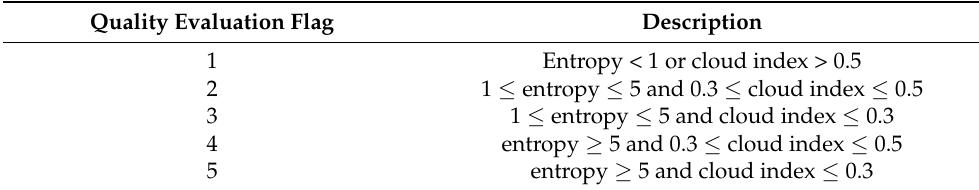
Table 10. Multiple scattering quality evaluation